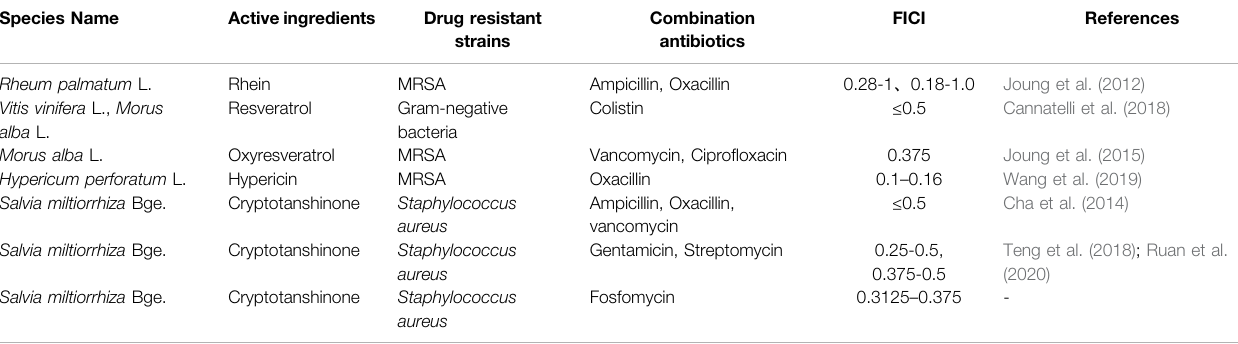
TABLE 4 | Summary of quinone compounds in combination with